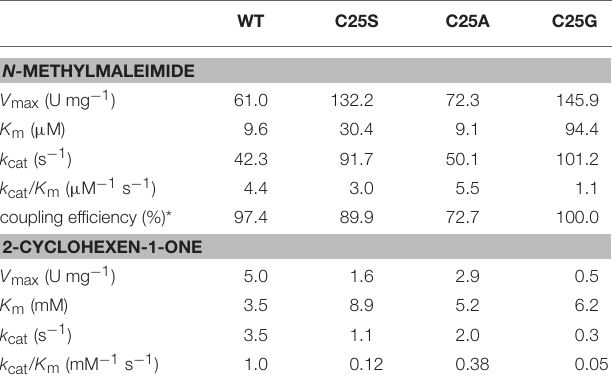
( Table 3 ). Compared to WT and C25A, C25S has a doubled k cat TABLE 3 | Steady-state kinetic parameters of OYERo2a WT and Cys variants regarding substrate